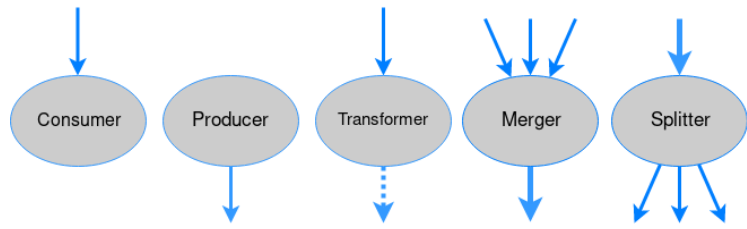
Figure 3. Di ff erent functional Algorithms and their input and output